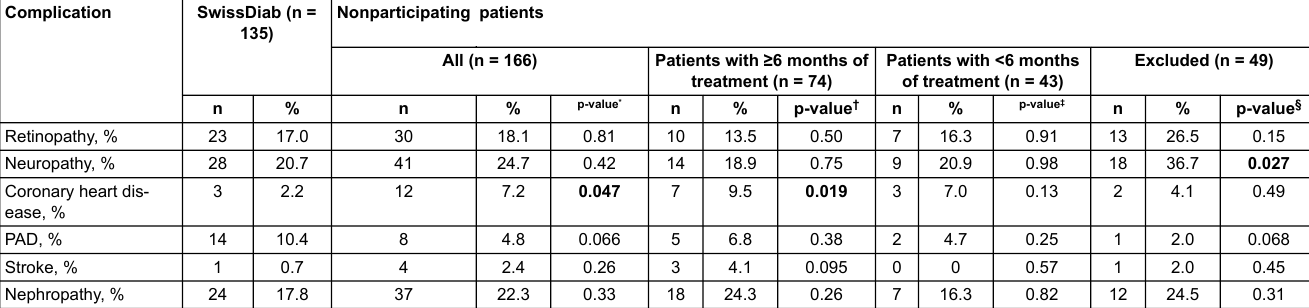
Table 2: Prevalence of diabetes-related complications in SwissDiab participants and nonparticipating patients with